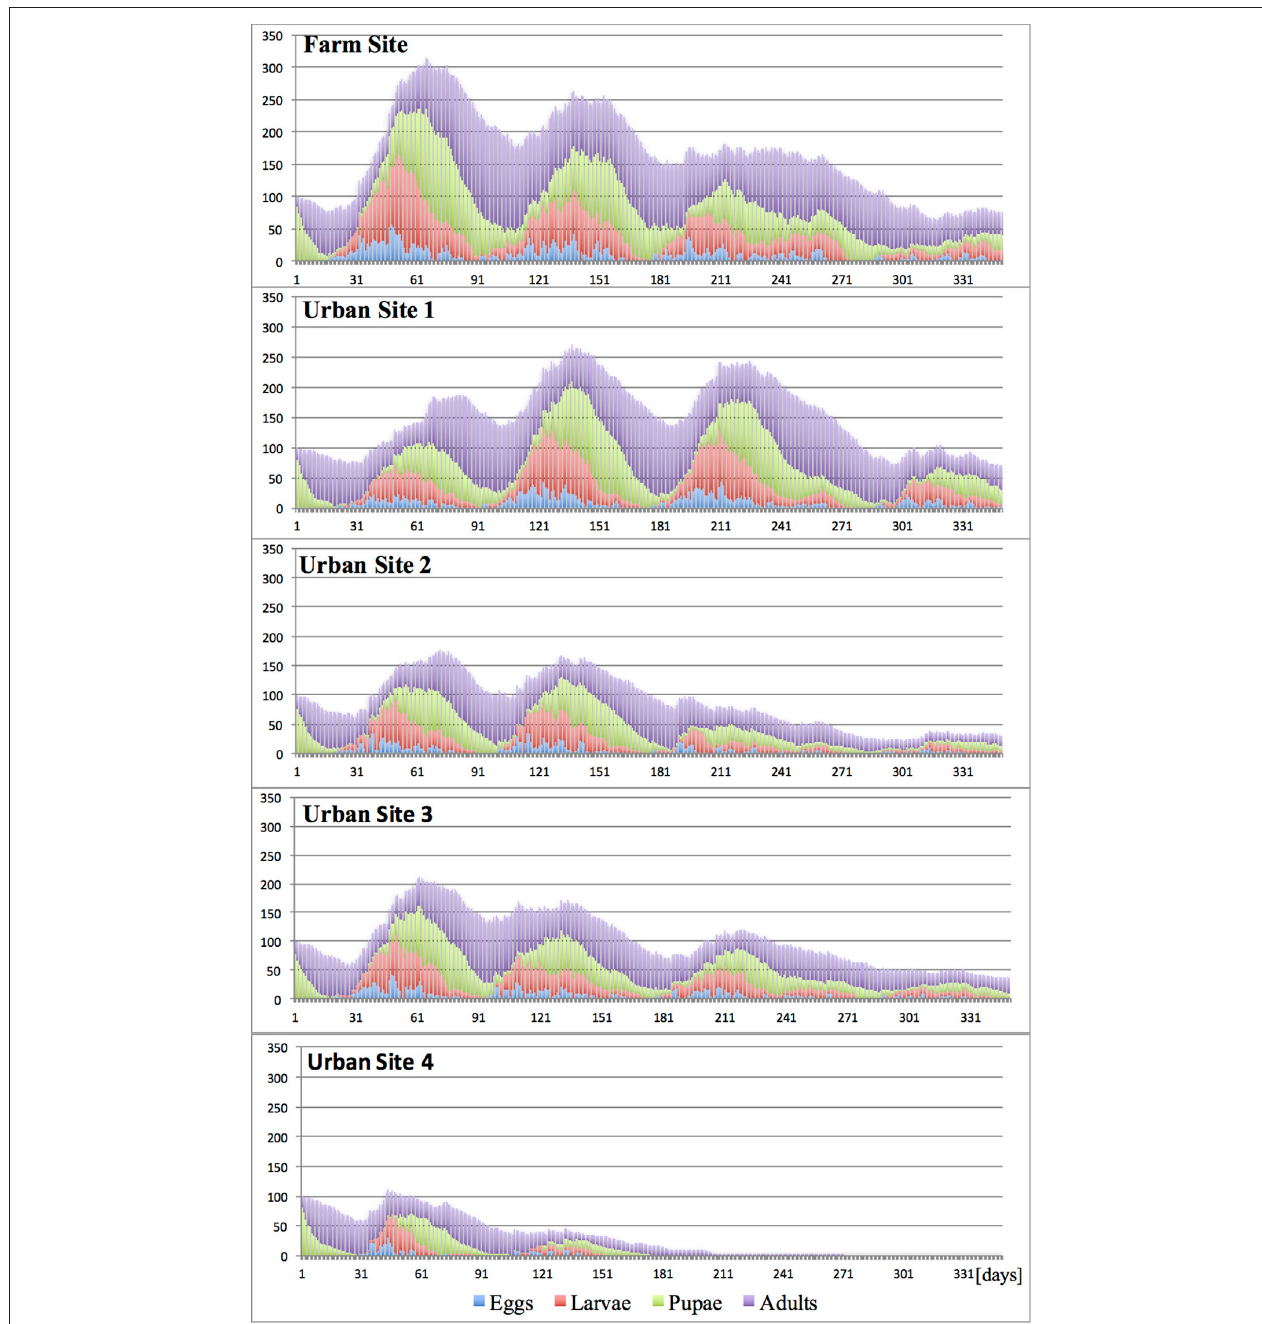
FIGURE 5 | Effects of site fragmentation on propagule development at constant temperature 20 ◦